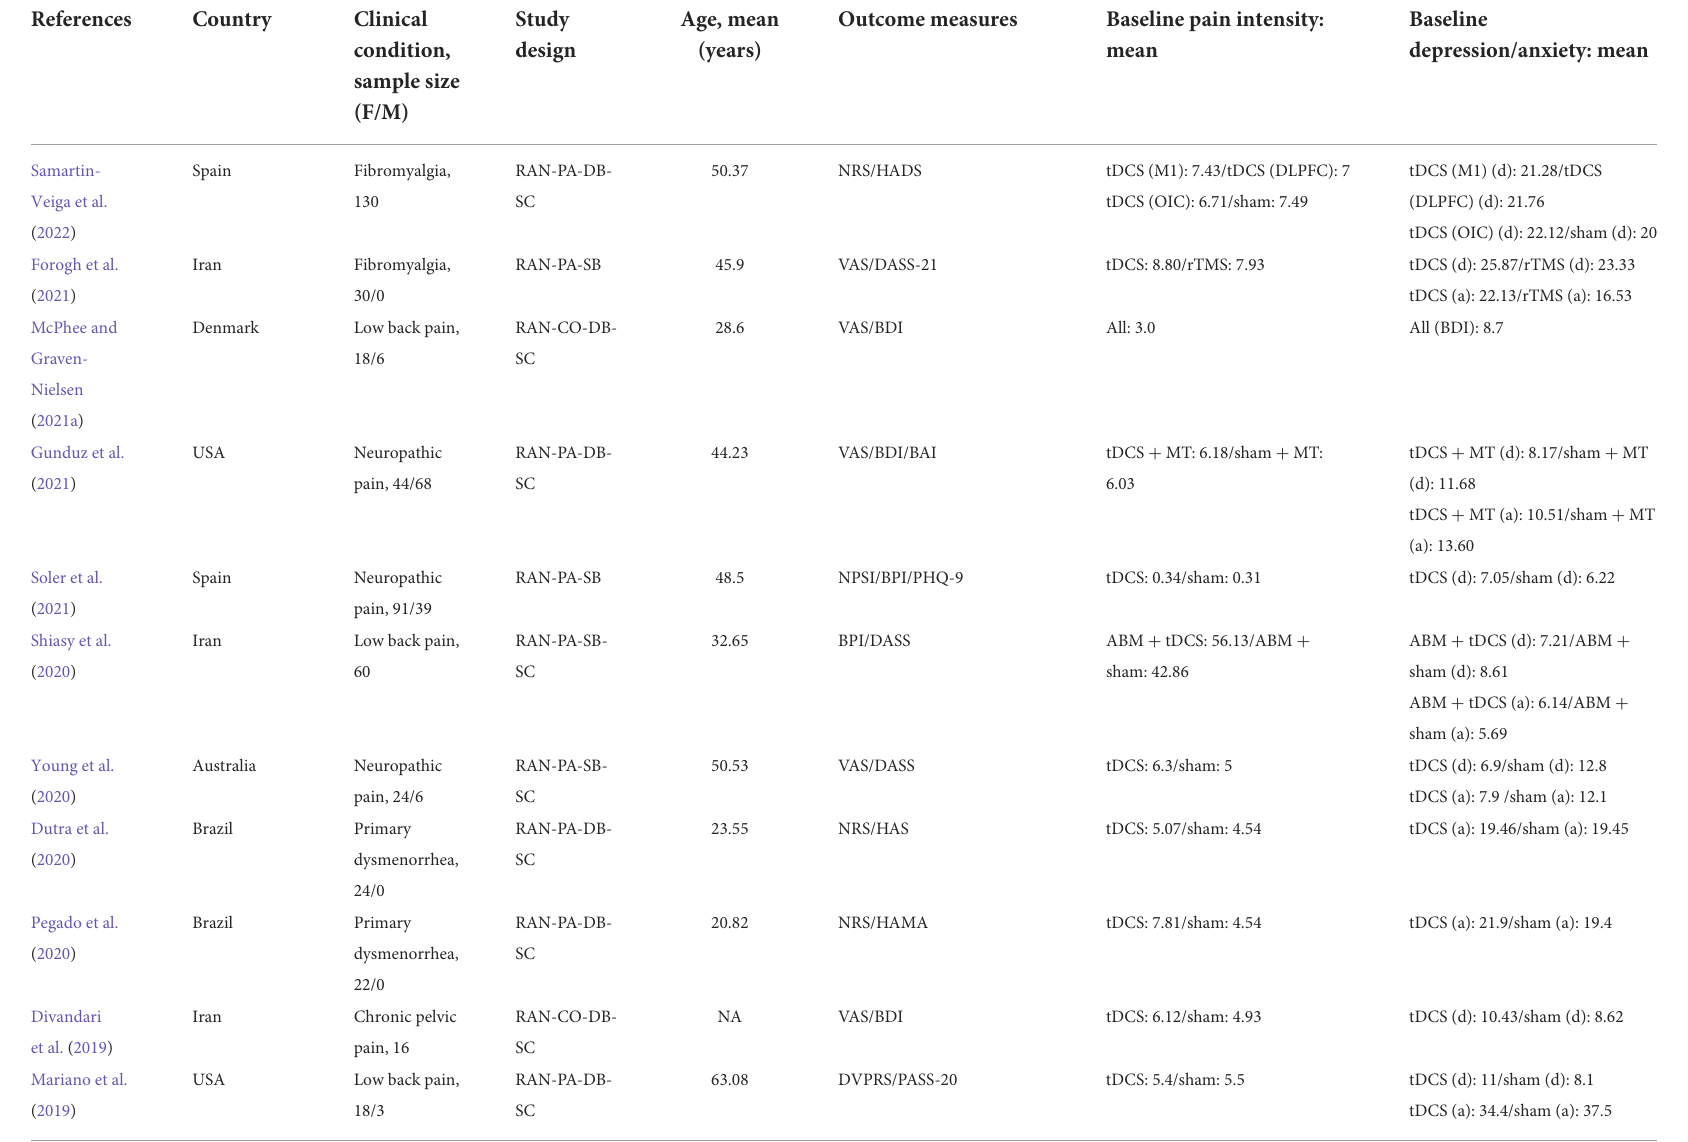
TABLE 1 Principal characteristics of included